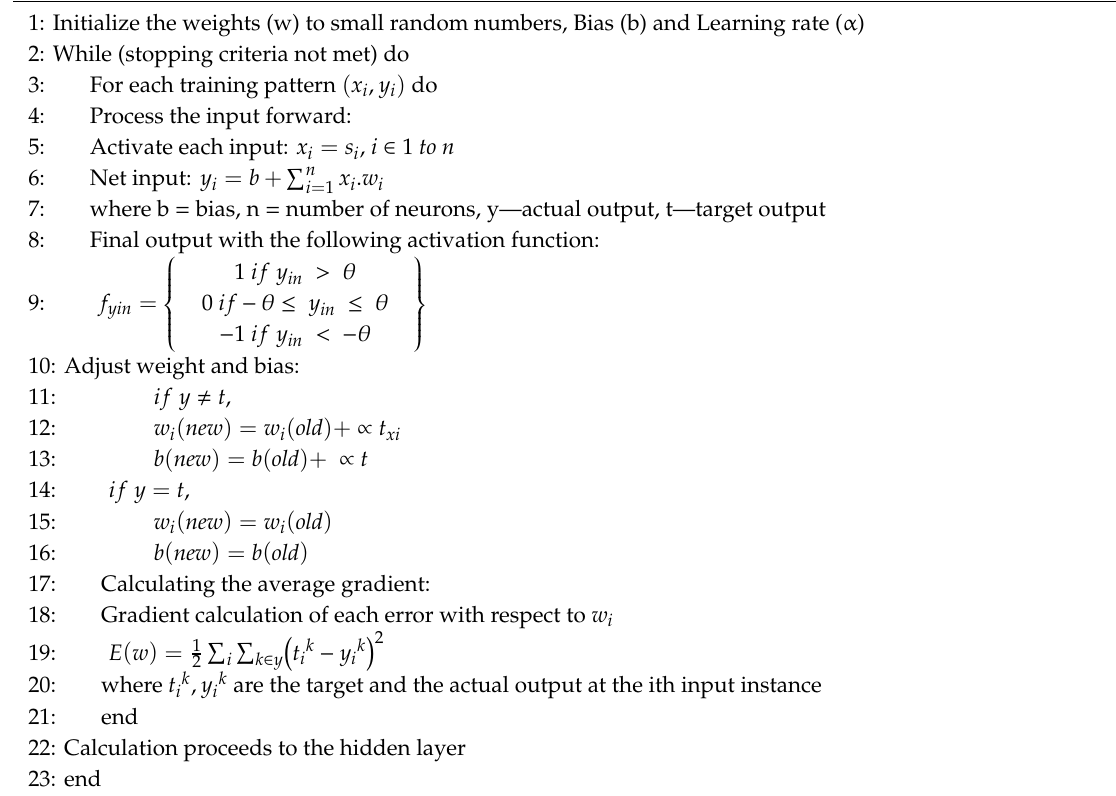
Algorithm 1 MLP Algorithm for Machine Learning